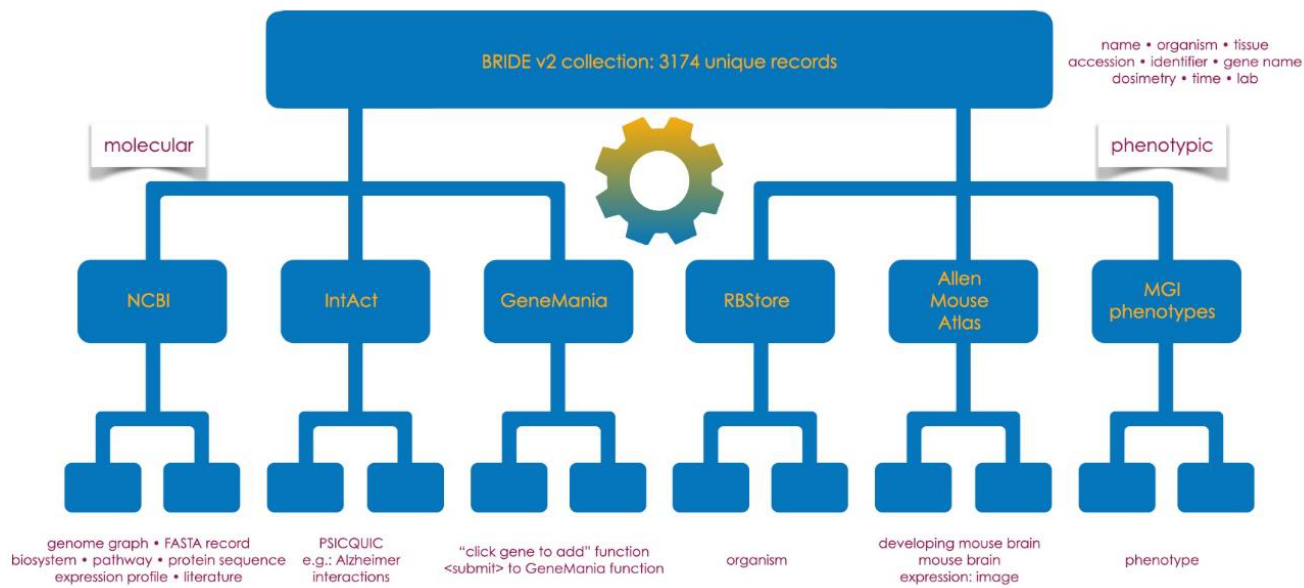
Figure 1. simplified view of functionality with contextual tools listed under each tab section. Figure 1. Simplified view of functionality with contextual tools listed under each tab